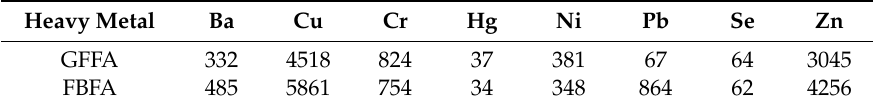
Table 2. The content of heavy metal in Grate Firing bed fly ash (GFFA) and Fluidized Bed fly ash (FBFA)